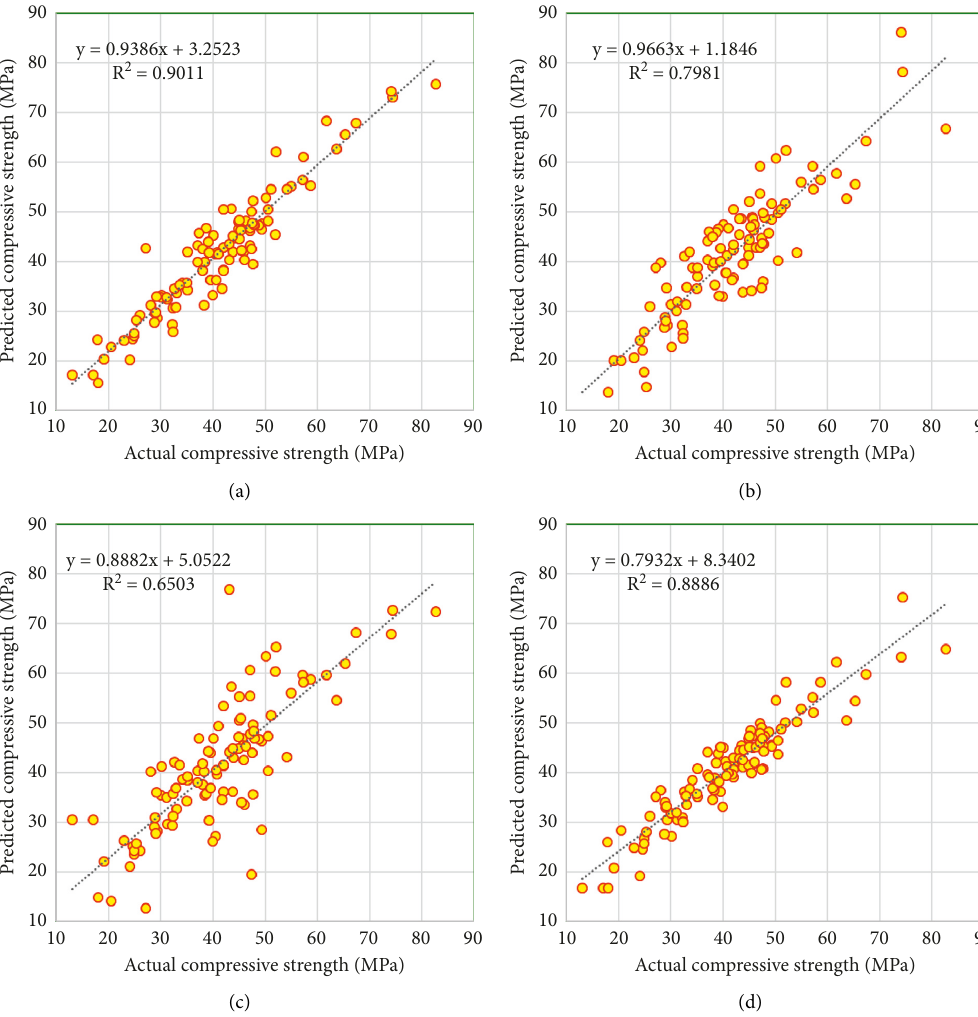
Figure 8: Scatter plot presentation using the developed AI model and for (70%-30%) data division scenario. (a) DLNN model. (b) MARS model. (c) ELM model. (d) RF